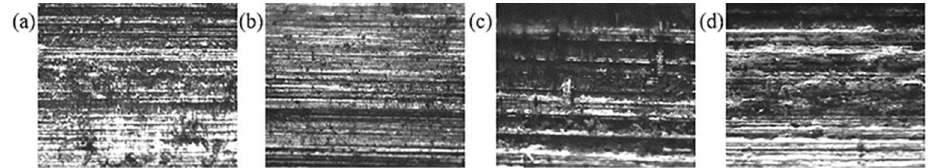
Figure 14. Slice diagram of 30 mm tooth width gear from tooth top to tooth root ( a ) the working surface of the gear, ( b ) the non-working surface of the gear, ( c ) tooth surface near the index circle, ( d ) adhesive wear phenomenon near the tooth root.